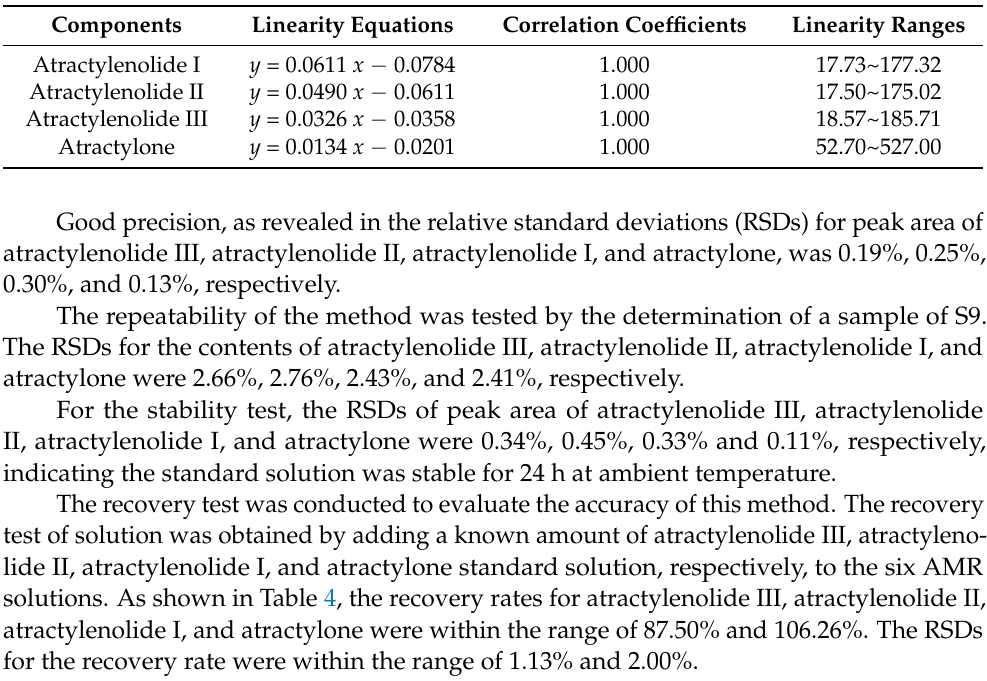
Figure 7. S-plot diagram of 27 batches of AMR sample. Table 3. Linearity equations, correlation coefficients, and linearity